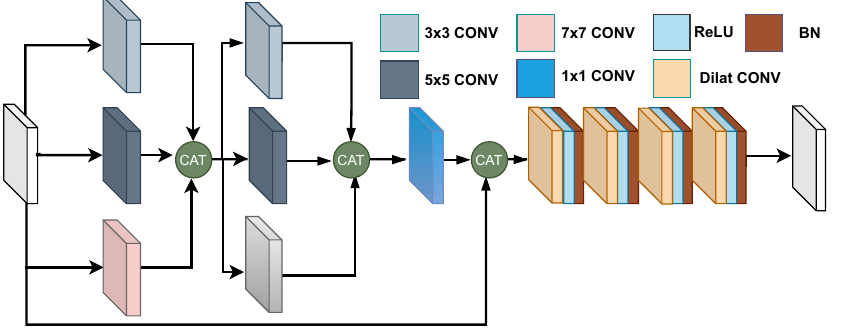
Figure 2. The MSDB in the NSRN